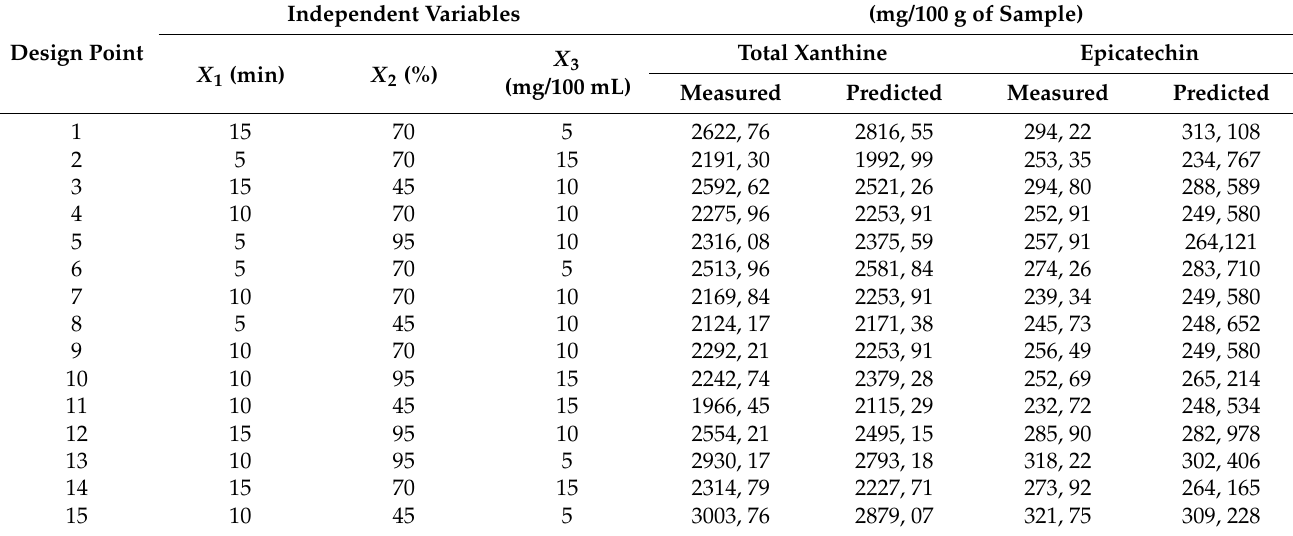
Table 3. Experimental measured and predicted values of the independent variables, for different points in the experimen- tal